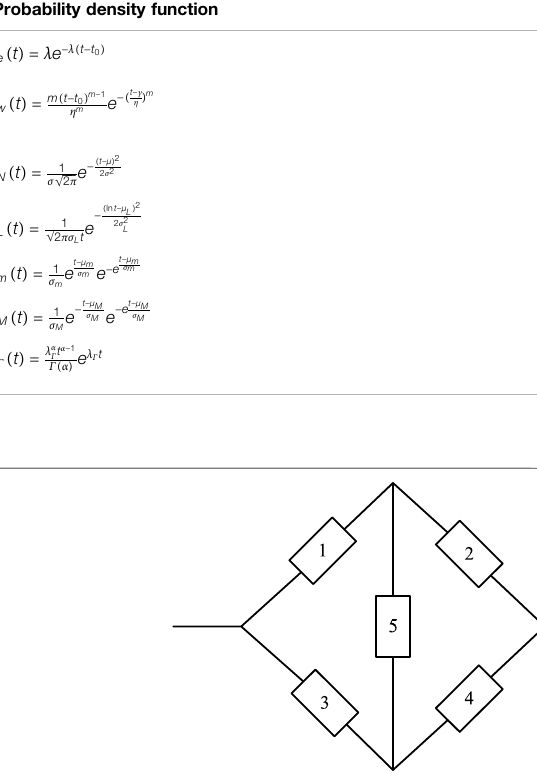
TABLE 1 | Conversion formulas of different distributions. Probability density function Distribution function